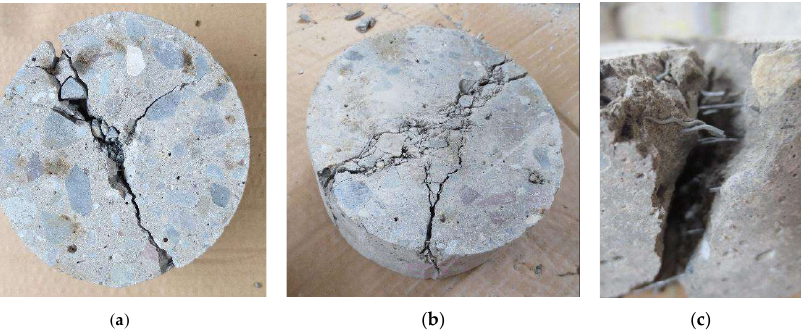
Figure 28. Specimens after impact test: ( a ) plain concrete, ( b ) steel fiber reinforced concrete, ( c ) fiber bridging.